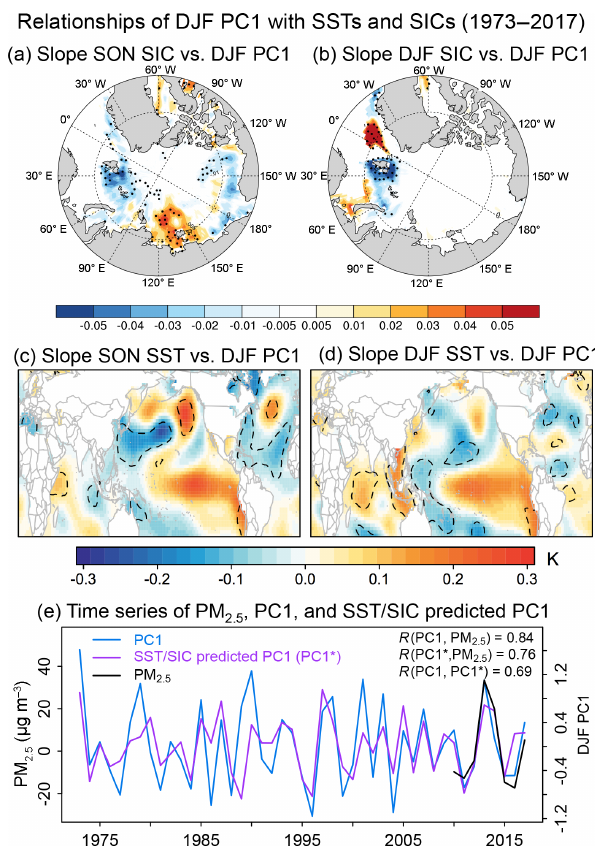
Figure 3. Relationships of sea ice concentrations (SICs) and sea surface temperatures (SSTs) with Beijing winter haze diagnosed from the first meteorological principal component PC1 (Eq. 1) for 1973–2017. The slopes of the linear regressions for SICs in the (a) preceding autumn and (b) current winter vs. normalized PC1 are shown. Grid boxes with statistically significant correlations ( p < 0 . 1) are stippled. Panels (c–d) show the corresponding slopes of the linear regressions for SSTs. The dashed contour lines enclose regions in which correlations are statistically significant ( p < 0 . 1). Panel (e) shows the time series of observed wintertime mean PM 2 . 5 concentrations in Beijing, PC1, and the predicted PC1 (PC1*) from SST and SIC (see text). The correlation coefficients of different time series are shown inset. For all panels, data are detrended by subtract- ing the 7-year moving average. The correlation coefficient of PC1 with PM 2 . 5 ( R = 0 . 84) is lower than in Fig. 1 ( R = 0 . 90) because it is calculated here from seasonal rather than monthly average